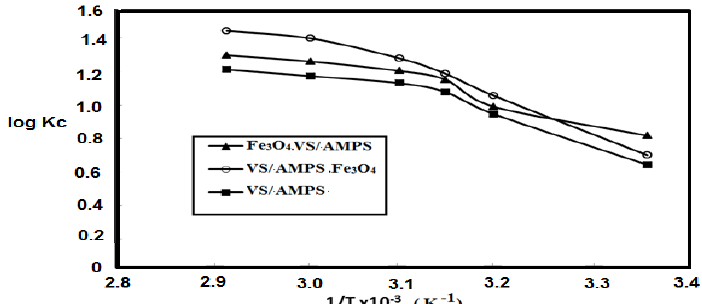
Figure 11. The relations between equilibrium concentration constant of VS/AMPS cryogels and the temperatures of the MB aqueous solutions using.